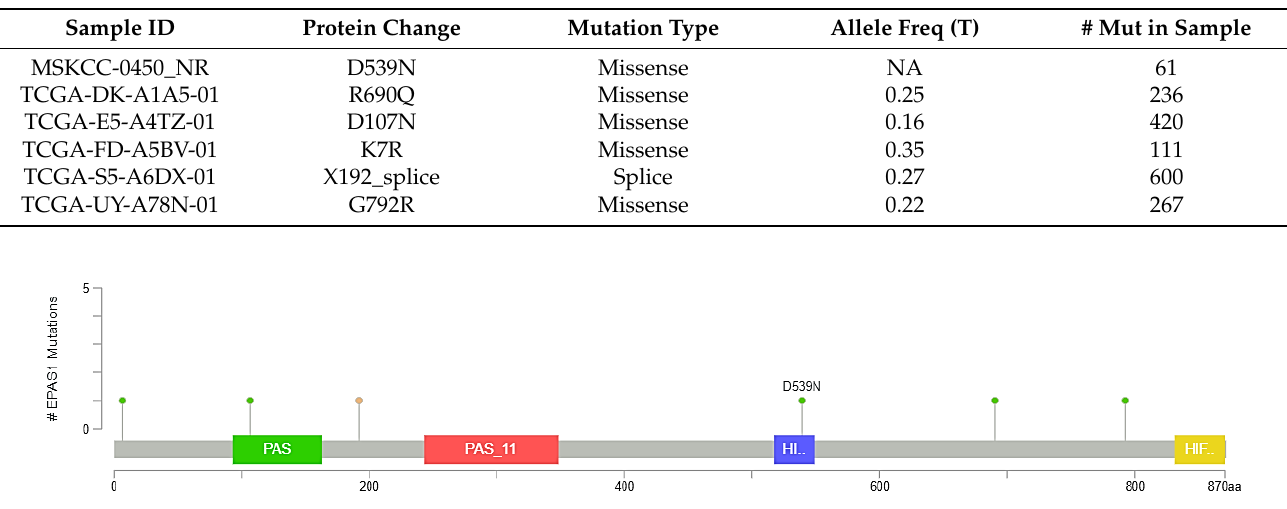
Figure 4. Lollipop plot of EPAS1 mutations in MSK/TCGA 2020 cohort (n = 476). # Number of mu-